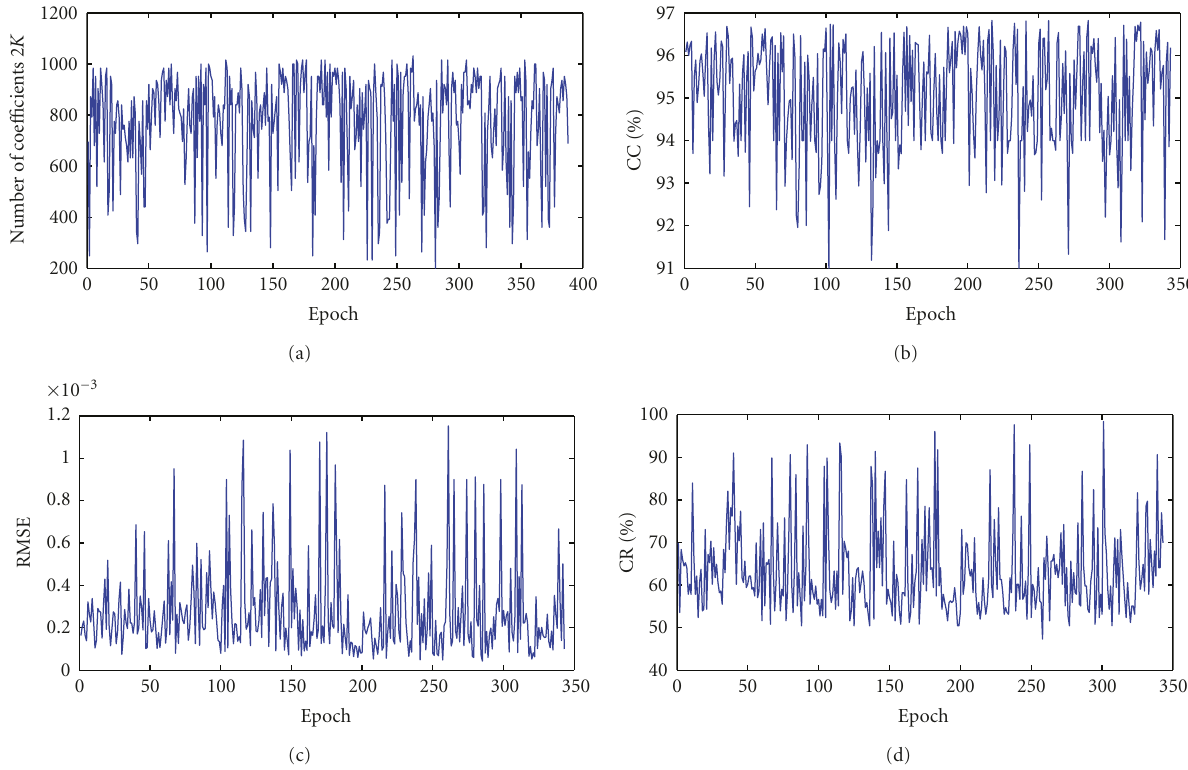
Figure 10: Variation of the evaluation metrics on 343 epochs corresponding to 3430 seconds of continuous EEG from one patient. (a) The number of coe ffi cient 2 K versus epochs. (b) CC versus epochs. (c) RMSE versus epochs. (d) CR versus epochs. K zeros at u k = e − i (2 πt k /τ ) , that is, A ( z ) =